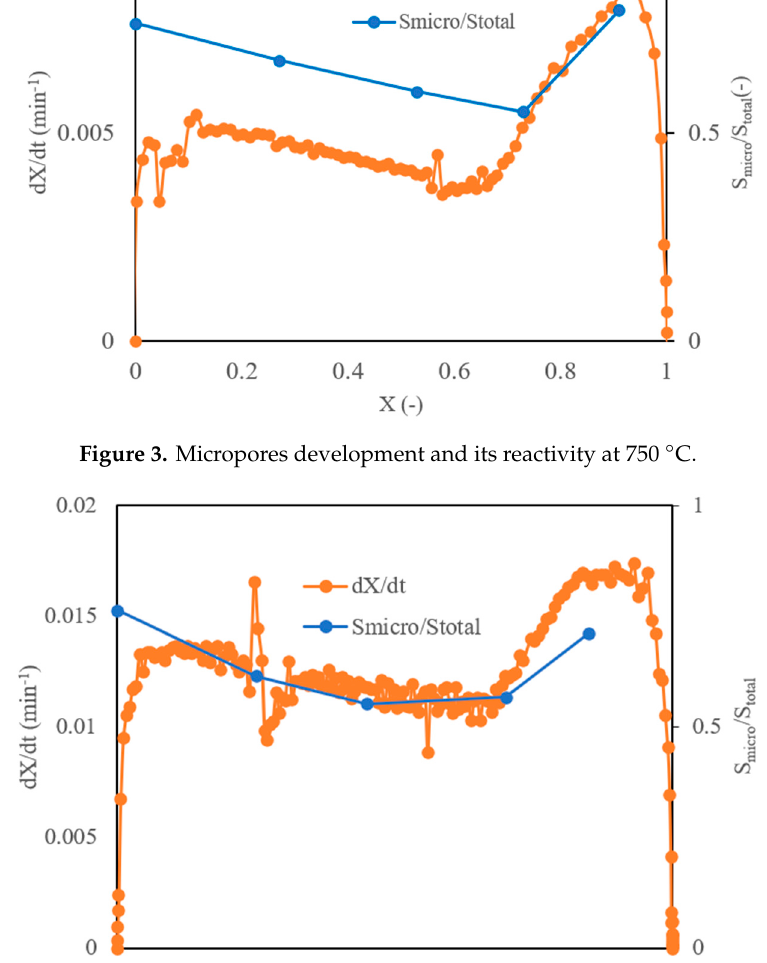
Figure 4. Micropores development and its reactivity at 800 °C.